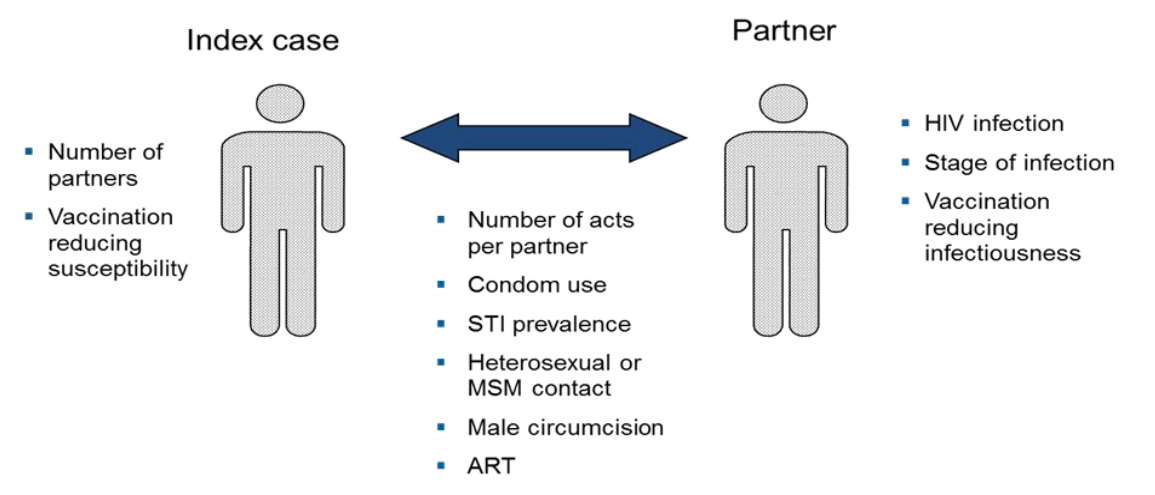
Figure A2. Determinants of Risk of